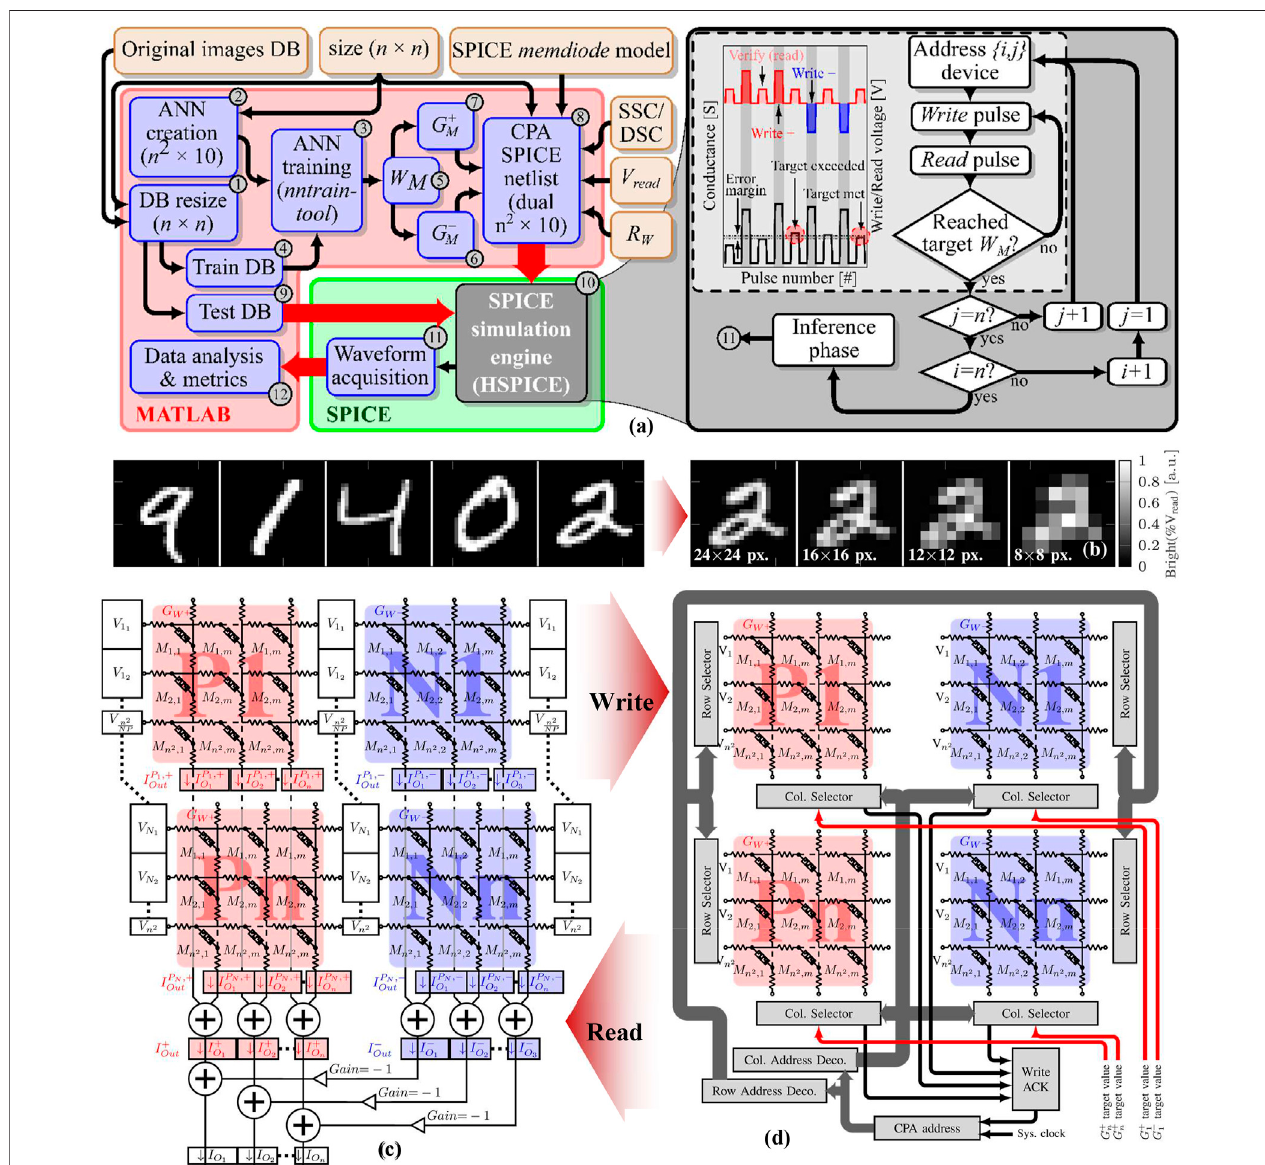
FIGURE 5 | (A) Flowchart diagram for the simulation procedure. Starting with the image size speci fi cation, R L , V read , and connection scheme, the routine creates the database, trains the SLP, maps the information intothe CPA, adds theperipheral control circuit, performs the simulationsand processes the results. MATLAB tasks are grouped by the red box and SPICE operations by the green box. The details of the programming phase simulated in SPICE are shown in the right side. (B) Sample imagesfromtheMNISTdatabase.Ontherightsidetheeffectoftherescalingispresented.Simpli fi edequivalentcircuitschematicforapartitionedCPA-basedSLP, for the inference (C) and programming (D) phases. Each CPA in the synaptic layer is subdivided into N identically sized partitions to minimize parasitic voltage drops. Partial output current vectors are indicated in the output of each partition. The peripheral circuitry connected to control the programming phase (write) is disconnected upon